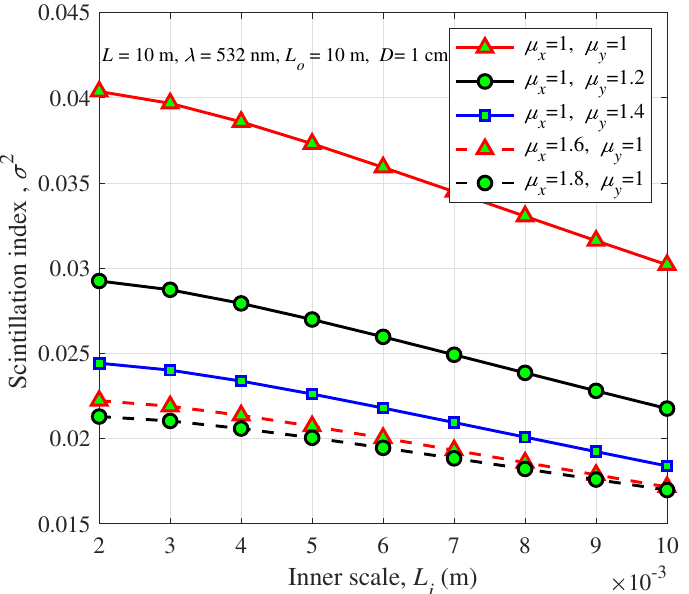
Figure 4. Scintillation index of a spherical wave versus the inner scale for different anisotropic